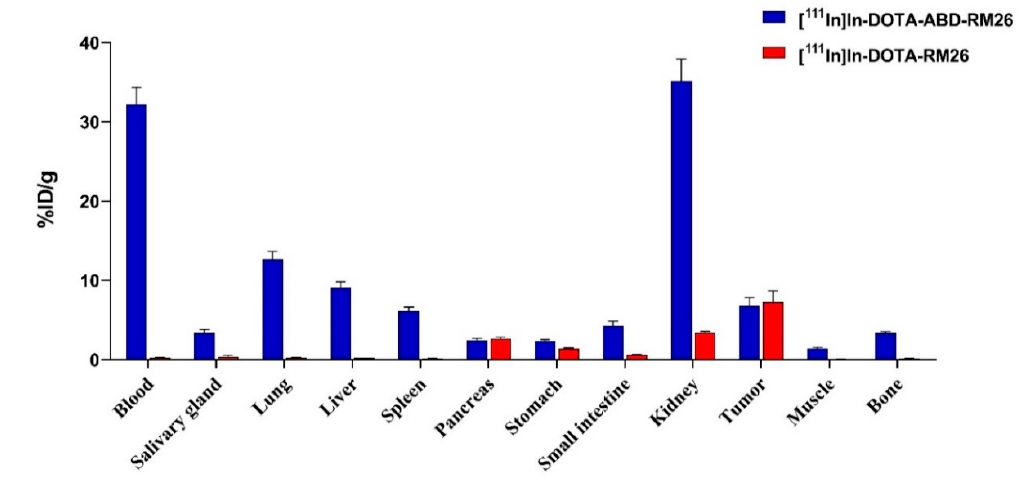
Figure 8. Comparison between biodistribution of [ 111 In]In-DOTA-ABD-RM26 and [ 111 In]In-DOTA-RM26 at 1 h pi. The error bars represent the standard deviation.